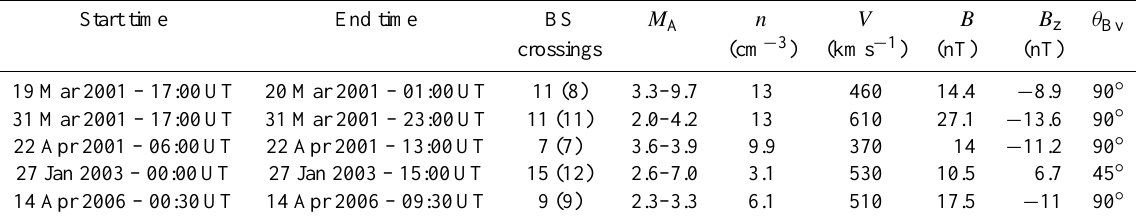
Table 1. Start and end time of the five low M A events, observed BS crossings and solar wind parameters. The numbers between parentheses in the third column correspond to the number of BS crossings taking place when M A < 5. The solar wind density, speed, IMF amplitude and B z component given in columns 5 to 8 are averaged over each event. The value of θ Bv given in column 9 refers to the version of the Chapman and Cairns (2003) model used in each